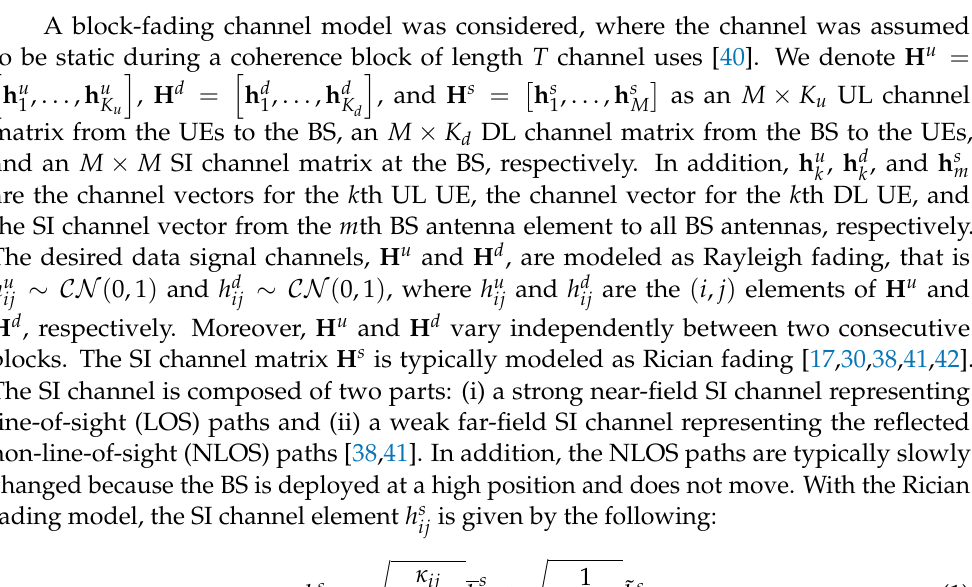
Figure 1. FD massive MIMO system